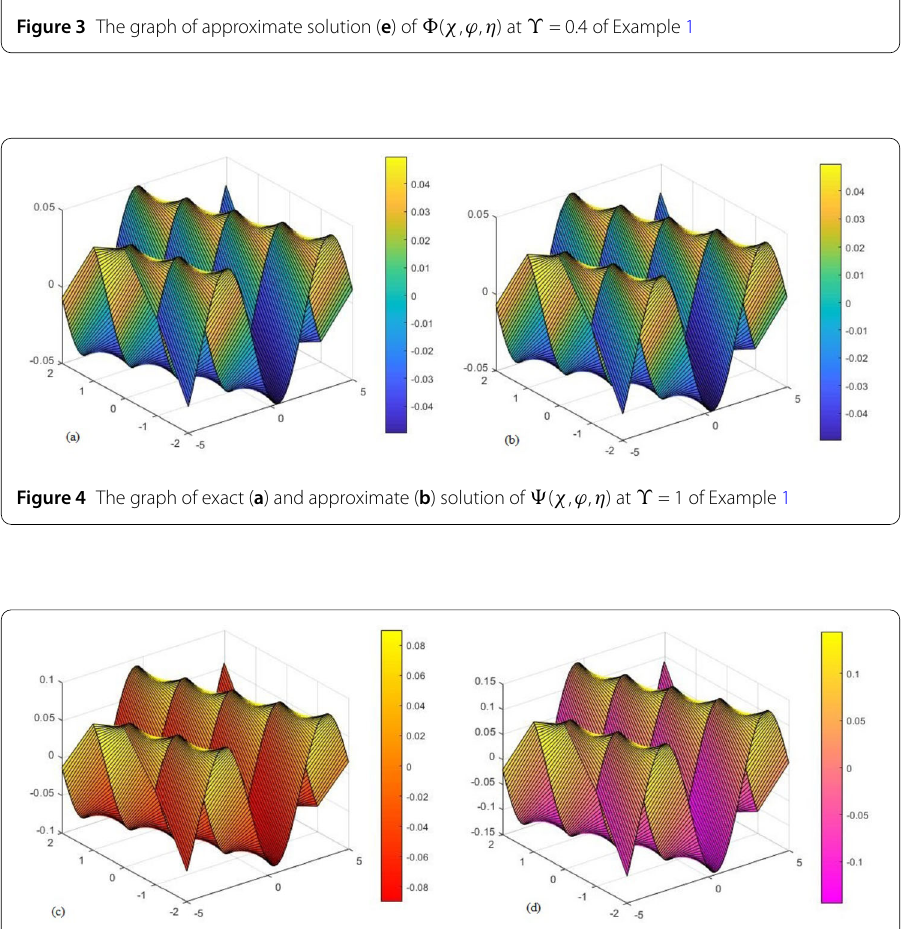
with the initial